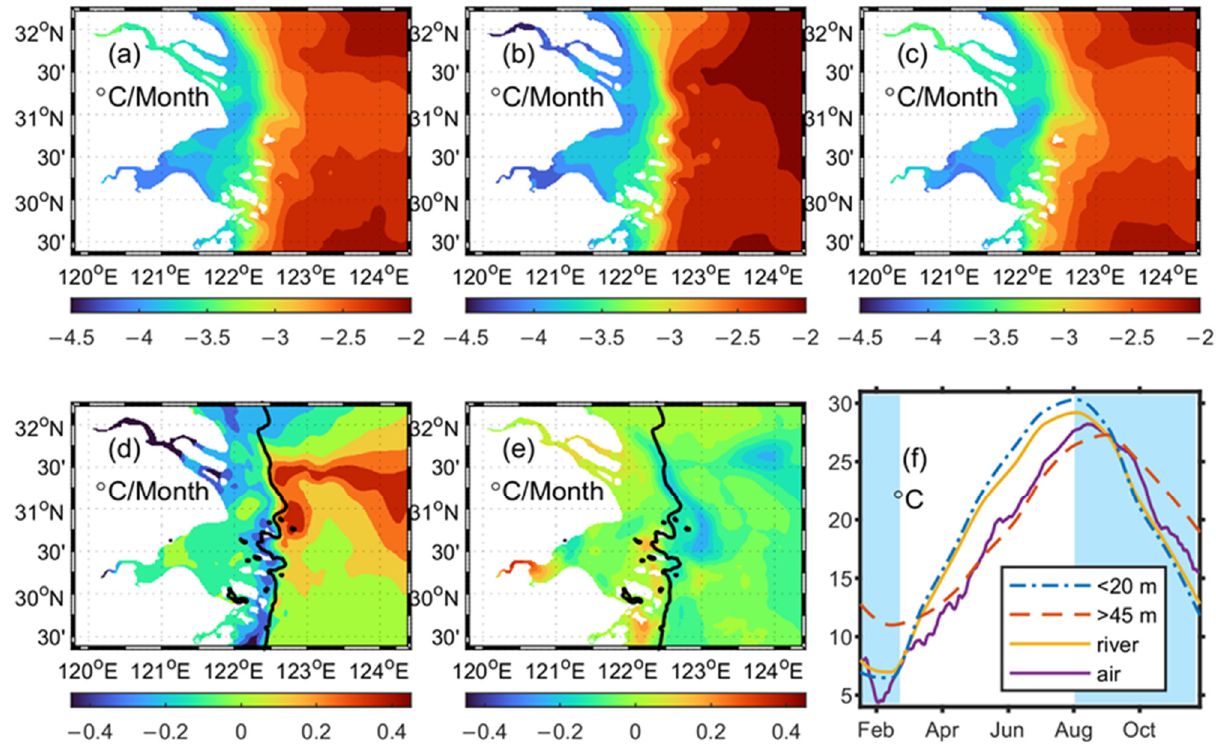
Figure 6. The effect of runoff on the cooling rate of surface temperature during the cooling season. ( a ) with real runoff flux in 2019, ( b ) without runoff flux, ( c ) with maximum runoff flux, ( d ) b minus a, ( e ) c minus a (the black lines indicate 20 m isobath), ( f ) the variation in the nearshore shallow sea temperature, offshore deep sea temperature, CR inflow temperature and air temperature near sea surface, the blue shaded areas indicate the cooling season.